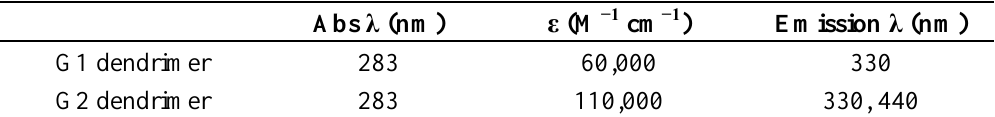
Table 1. Optical properties of G1 and G2